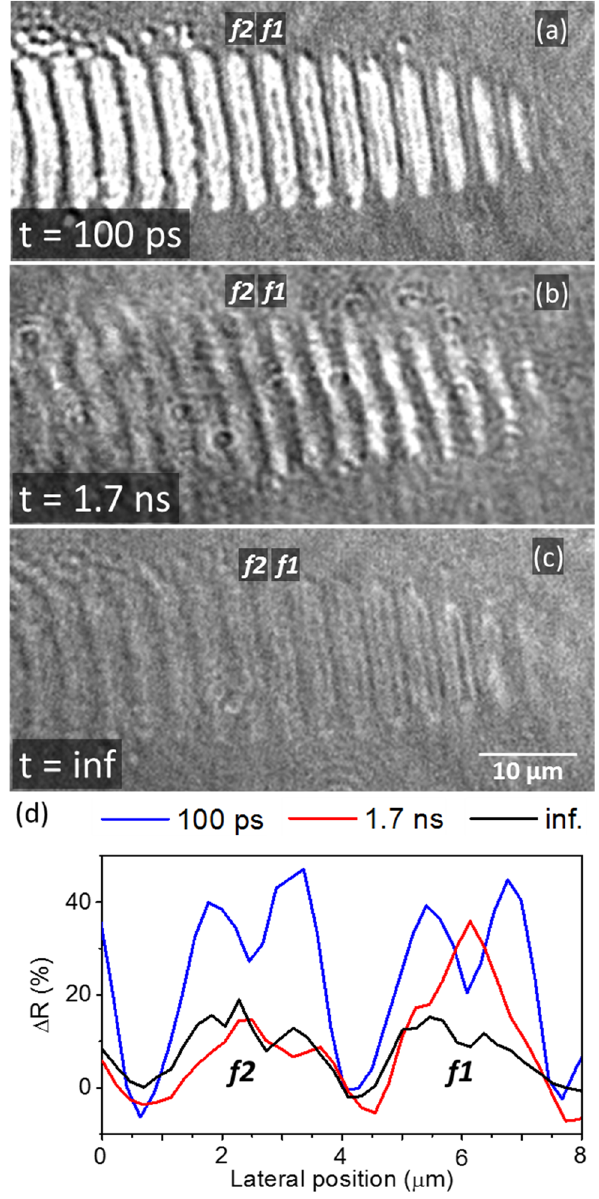
Figure 10. ( a – c ) Time-resolved optical micrographs of Λ s + fringe structures being written upon irradiation of a moving Si sample (towards the left) with fs laser pulses at oblique incidence ( θ = 52° ). The delay times are indicated in the figures and t = inf . refers to a delay of several seconds. ( d ) Horizontal profiles through the fringes f1 and f2 indicated in ( a – c ), quantifying the relative reflectivity change Δ